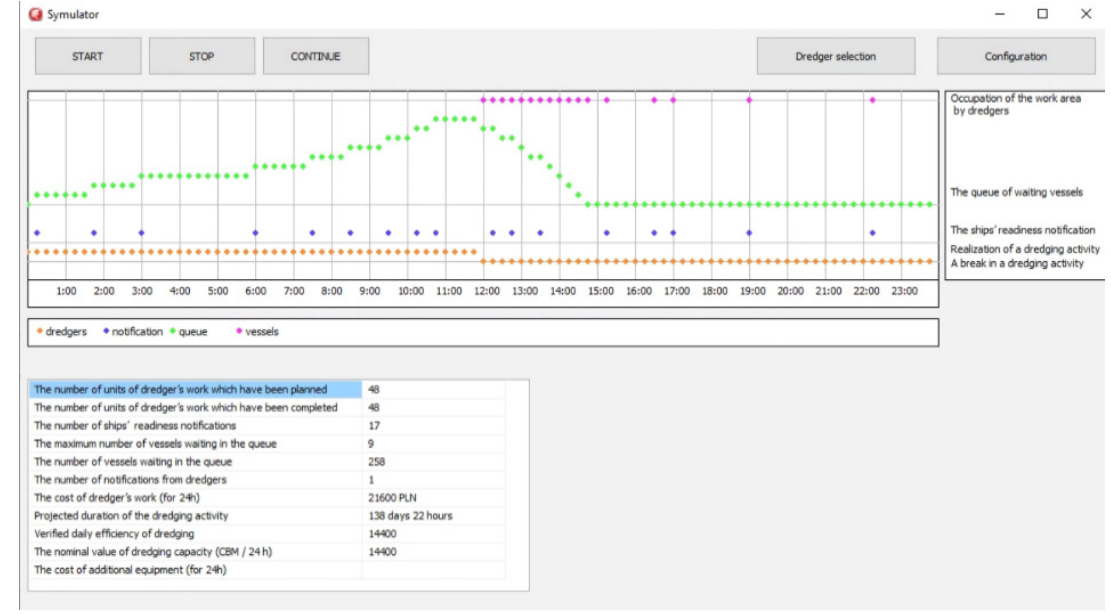
Figure 8. Figure from the computer program concerning costs.